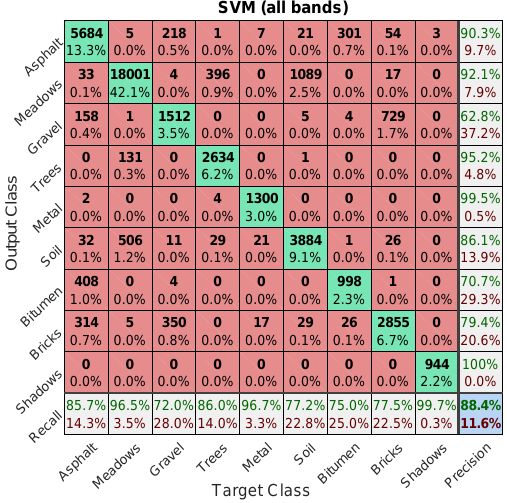
Figure 16. Confusion matrix for SVM with all bands.